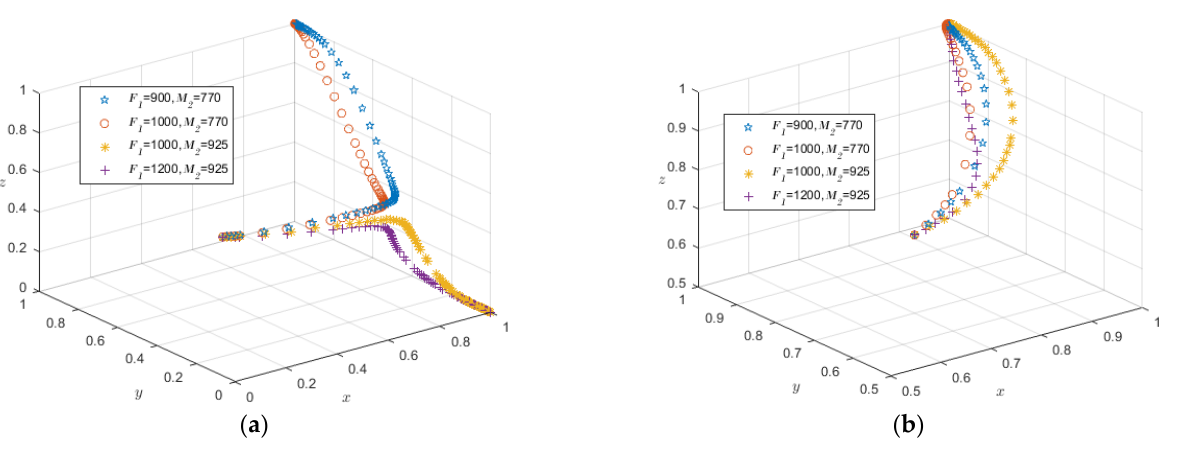
Figure 9. Evolution path of F 1 and M 2 under different values: ( a ) System A with (x 0 , y 0 , z 0 ) = (0.32, 0.48, 0.4); ( b ) System B with (x 1 , y 1 , z 1 ) = (0.7, 0.7, 0.7).